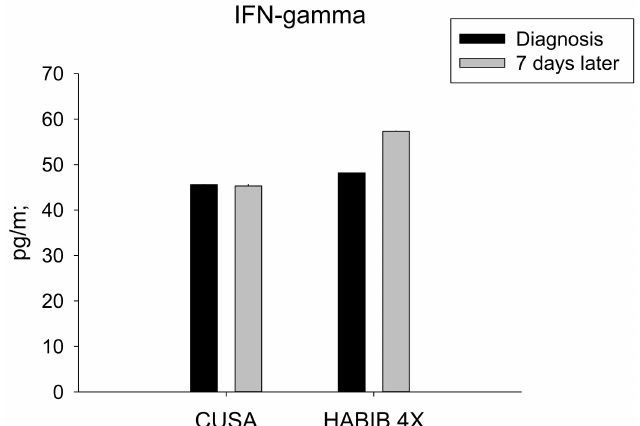
Figure 4. Serum IFN- γ changes in both study groups. A significant increase was noted in the Habib TM 4X